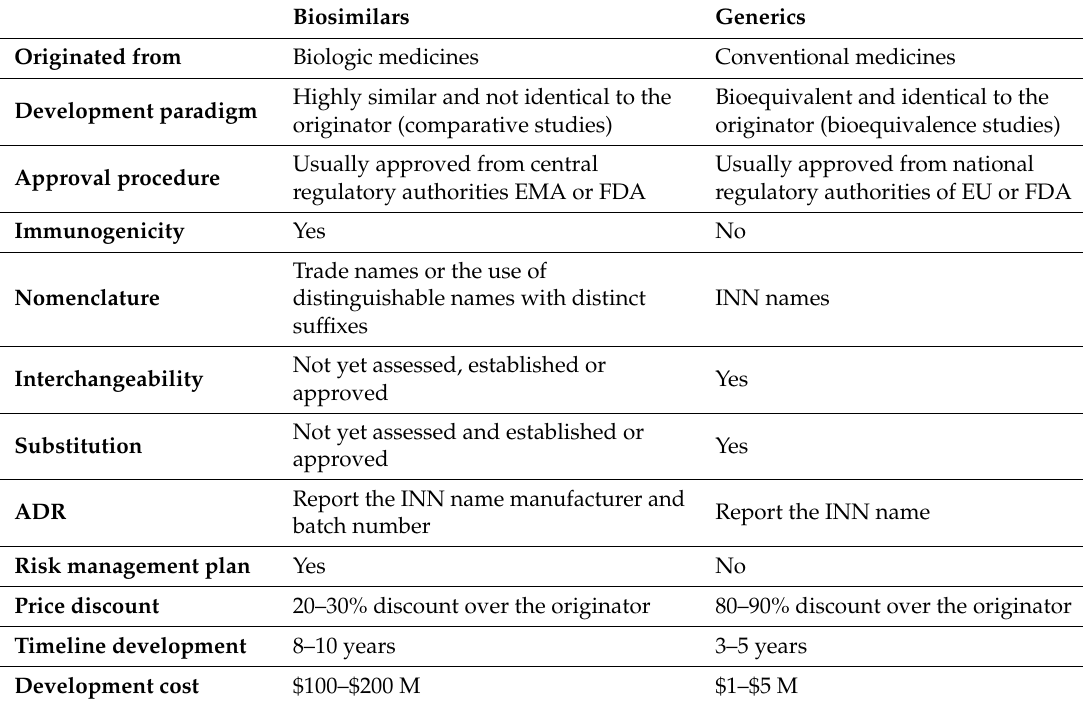
Table 4. Regulatory characteristics of biosimilars and